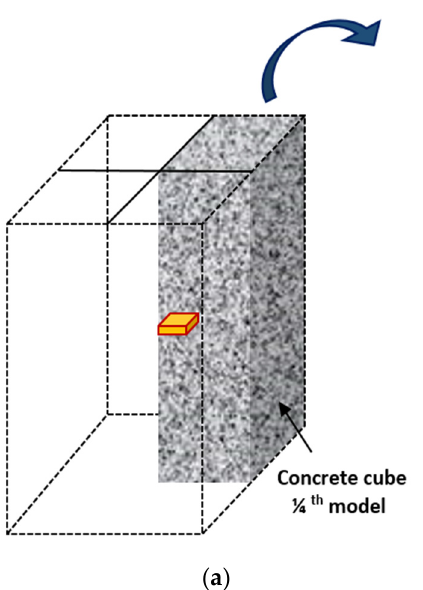
( d ) Figure 6. Representation of two-axis symmetry 3D model of ( a ) free-free PZT patch; ( b ) PZT patch with epoxy layer; ( c ) conductance and ( d ) susceptance plot based on the EMI measurement. Table 3. Properties of concrete. Parameters